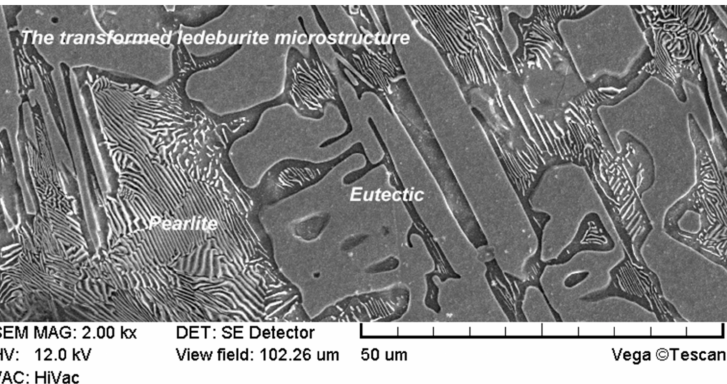
Figure 11. The microstructure of the surface layer of the cultivator coulter without laser modification.